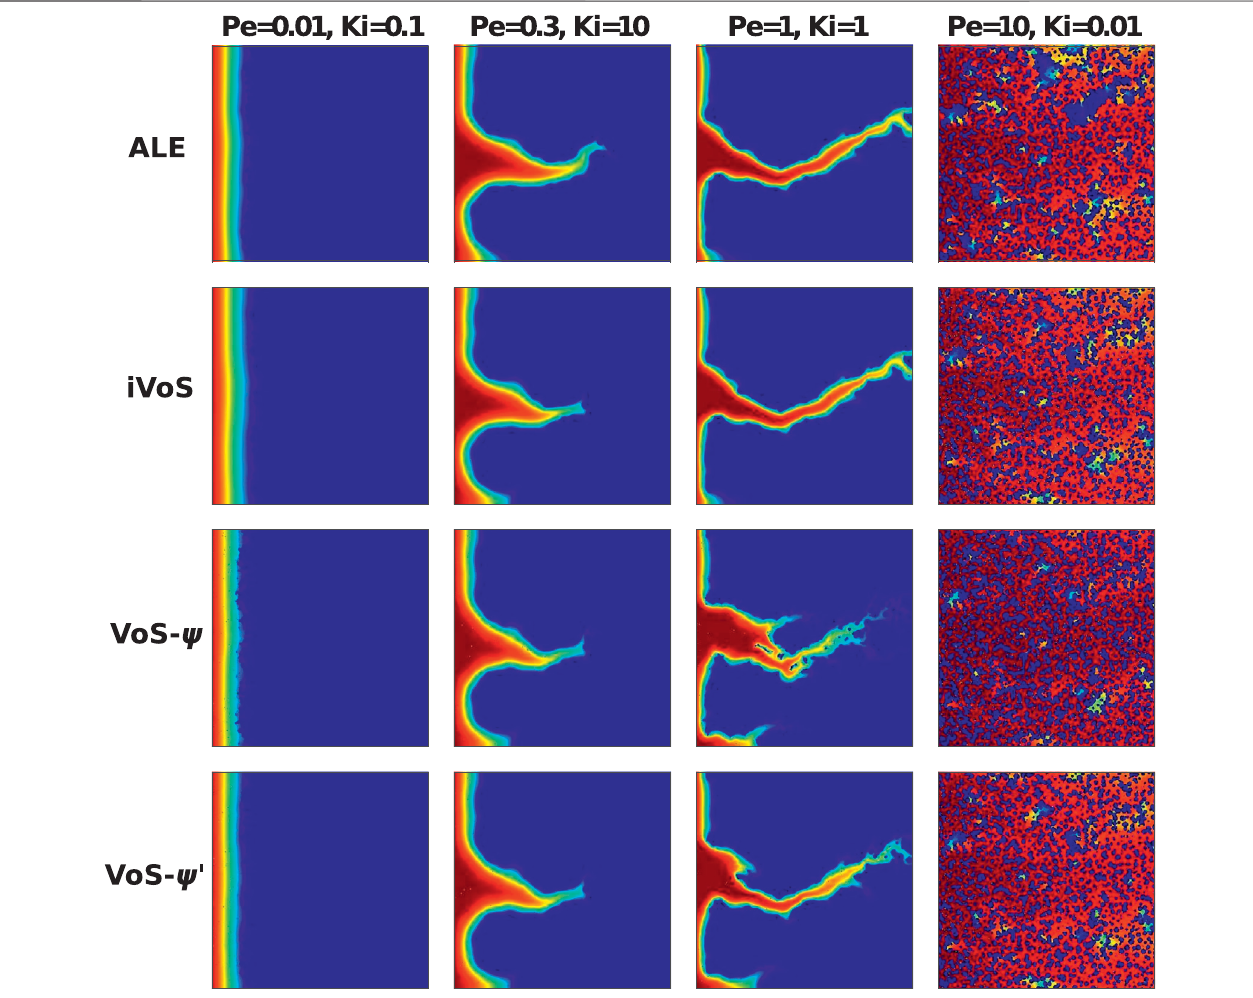
FIGURE 4 | Acid concentration map after 20% dissolution in a micromodel for four different regimes (Benchmark 2) obtained by numerical simulations.